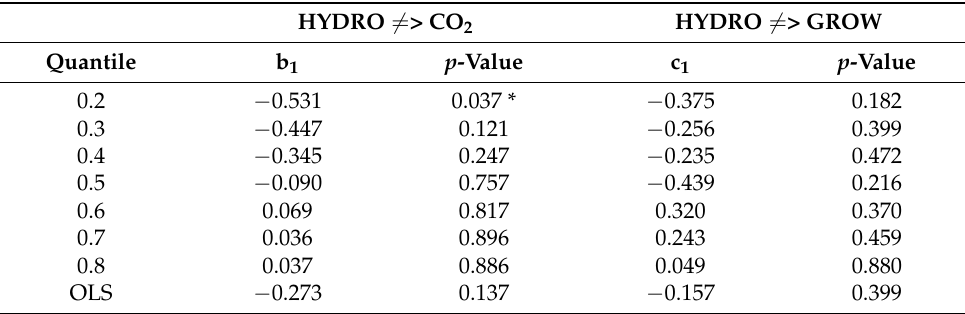
Table 2. The quantile results from HYDRO to CO 2 and from HYDRO to